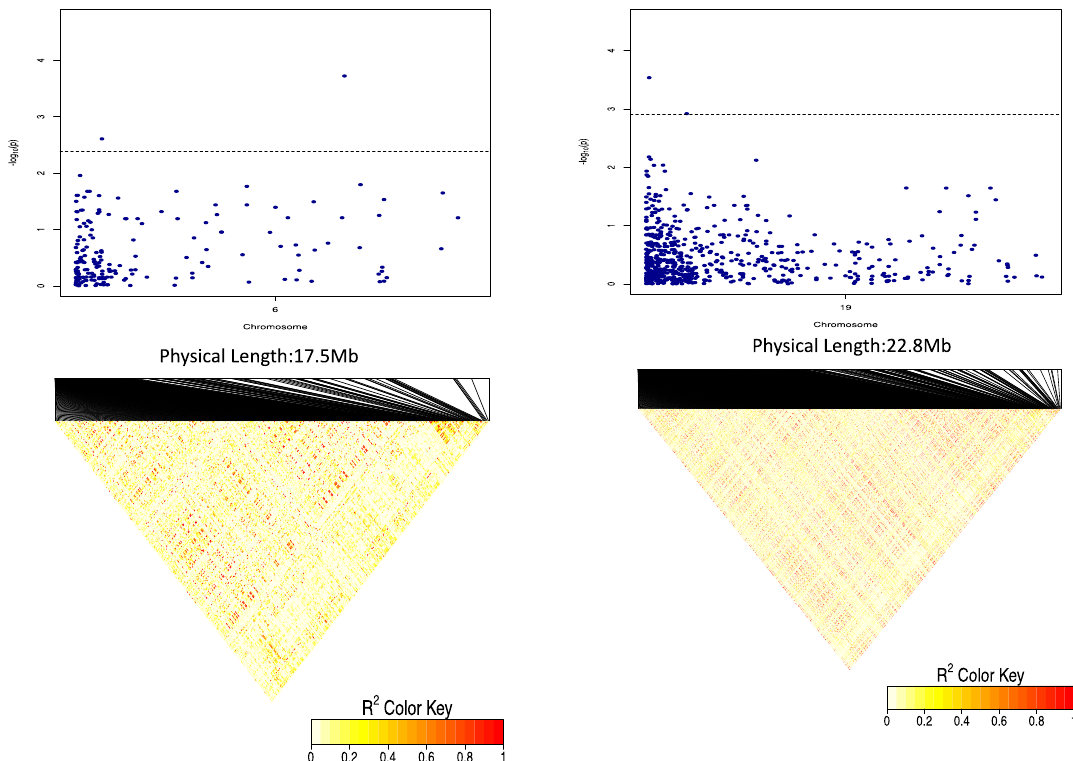
Figure 7. Linkage disequilibrium (LD heatmap) showing pairwise LD between the SNP markers covering the entire chromosomes 6 and 19, respectively, carrying the genes encoding for tuber DMC. The red colour shows the markers with high LD followed by yellow then the white colour. The dashed lines on the Manhattan plot represent the significant threshold while the X -axis presents physical distances.